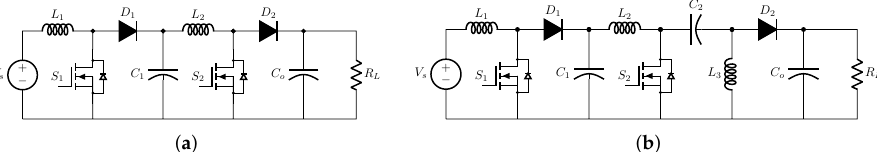
Figure 2. General Configuration of Cascaded DC/DC Converter ( a ) Symmetric ( b )